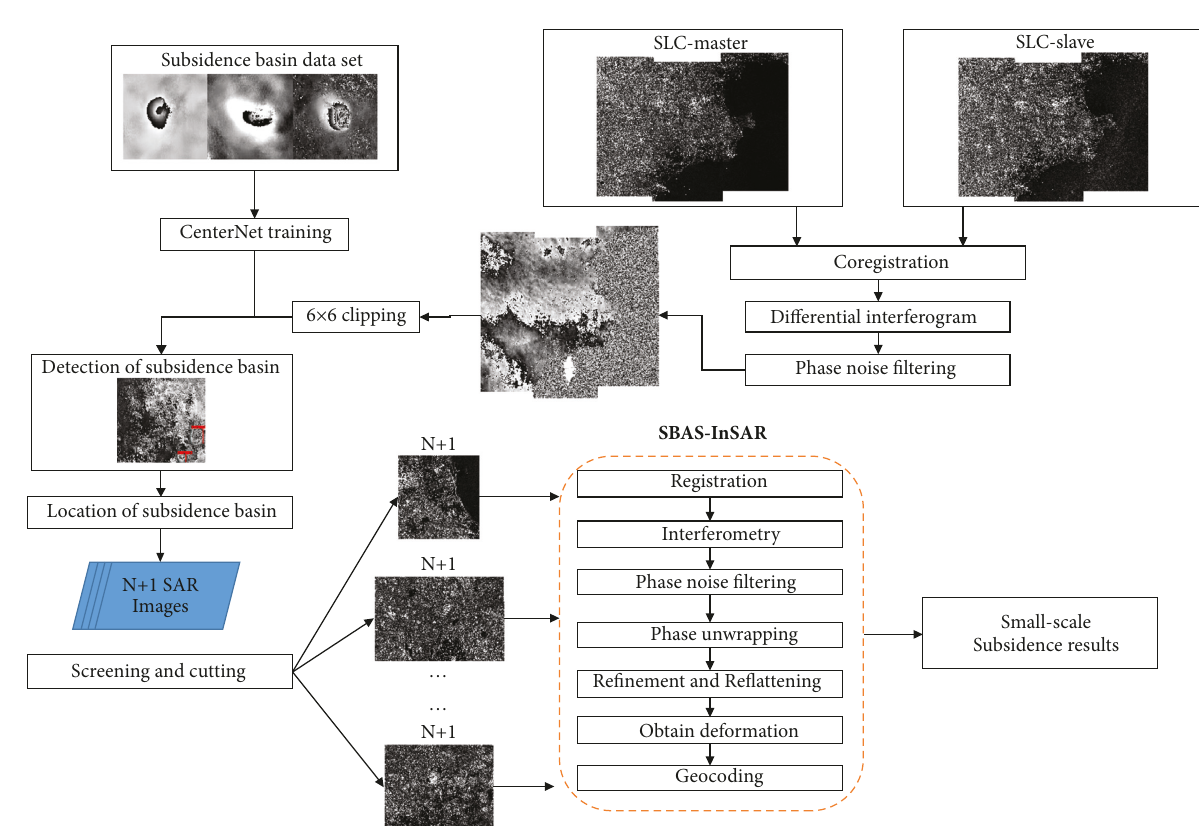
Figure 2: The flow chart of